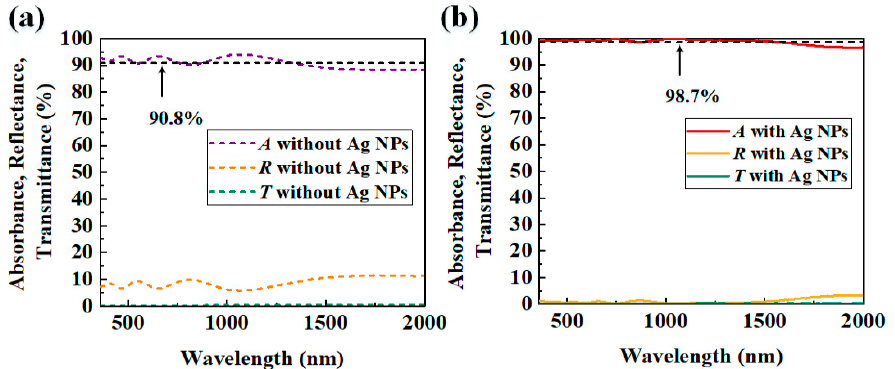
Figure 5. Measured reflectance, transmittance, and absorbance spectra of the nanostructured Si metasurface ( a ) without and ( b ) with Ag NPs after etching via the ICP process (the black dotted line corresponding to the average absorbance).